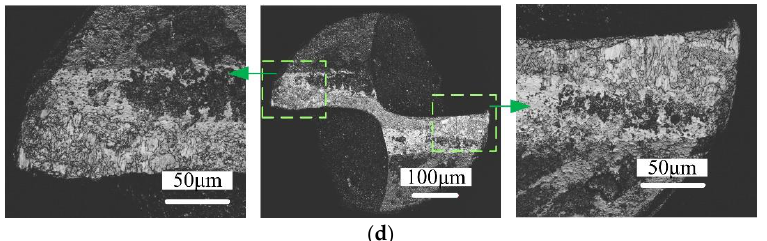
Figure 3. Surface morphologies end teeth flank faces of micro end mills with different coating materials ( v c = 20 m/min, f z = 2 μm/z, a p = 50 μm, 640 mm). ( a ) Uncoated micro end mill; ( b ) AlCrN-